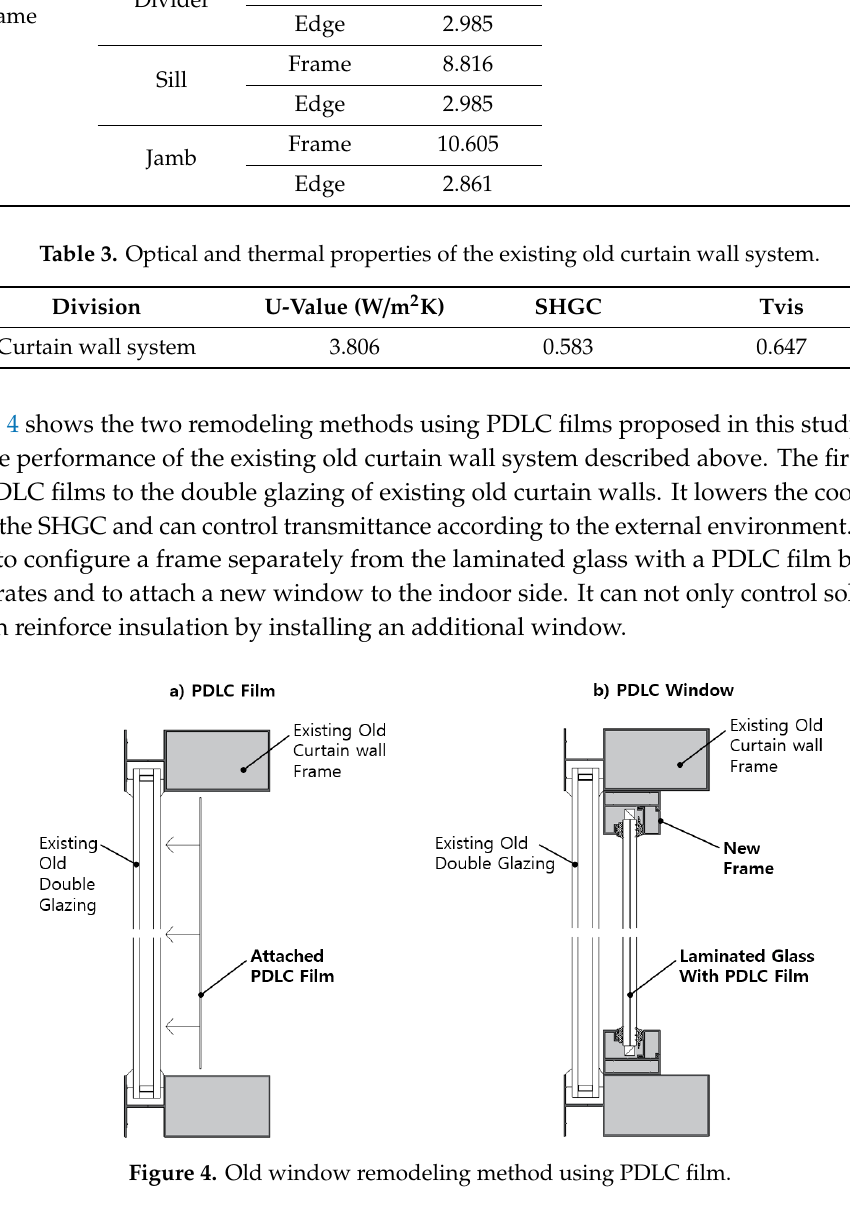
Table 3. Optical and thermal properties of the existing old curtain wall system.